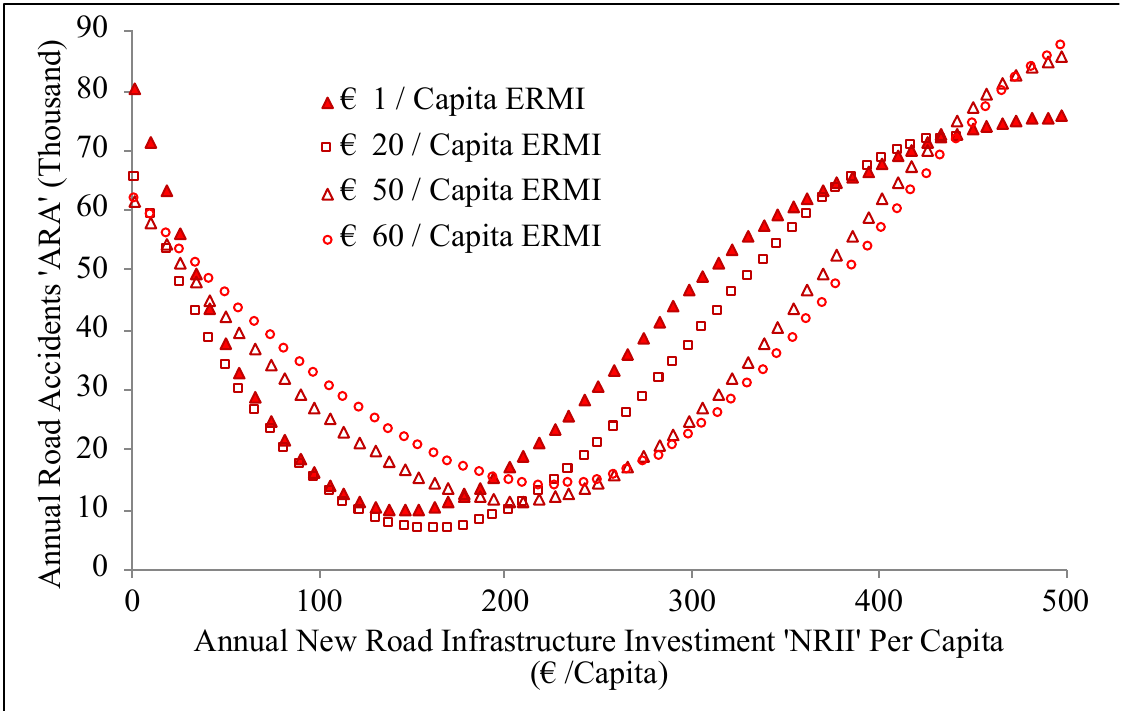
Figure 7. Annual road accident vs. ERMI and NRII per capita for a population of USD 10 million 40,000 GDP and Working Population of 70%.